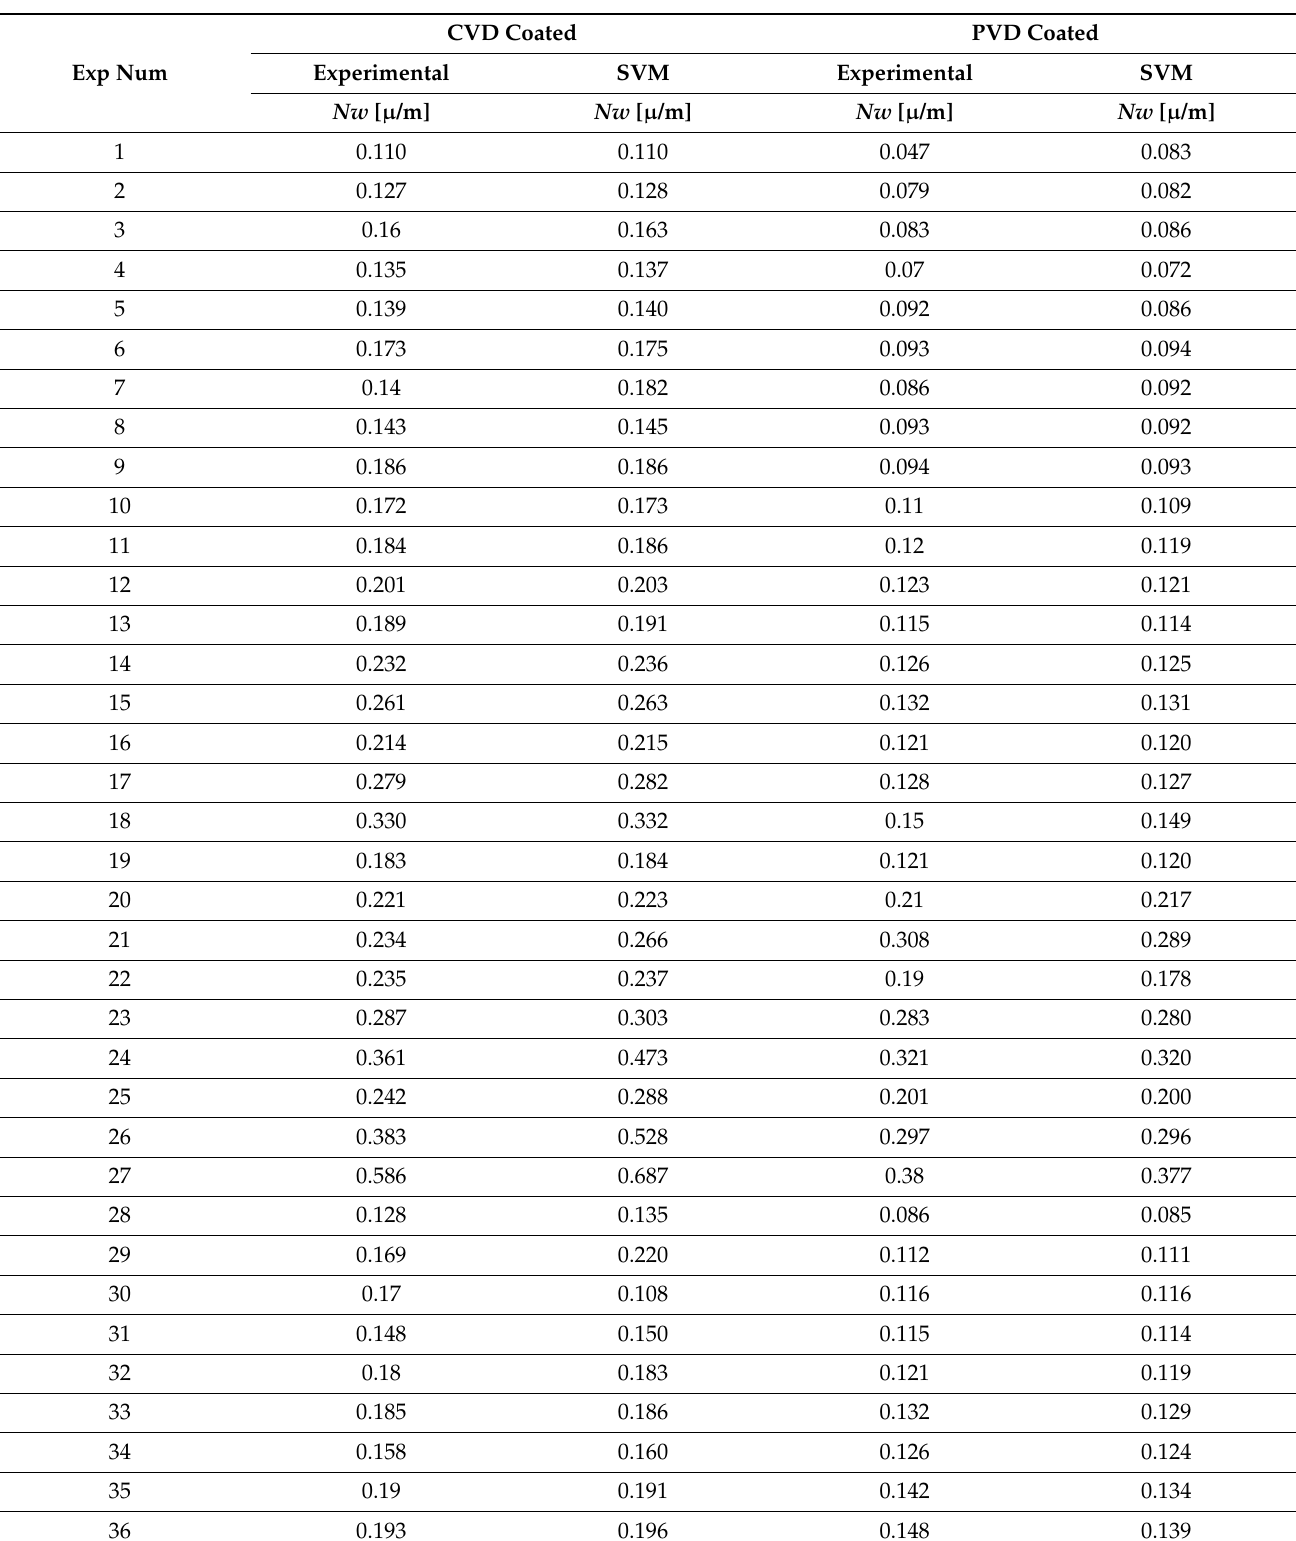
Table A2. Estimated cutting tool wear parameter of the training